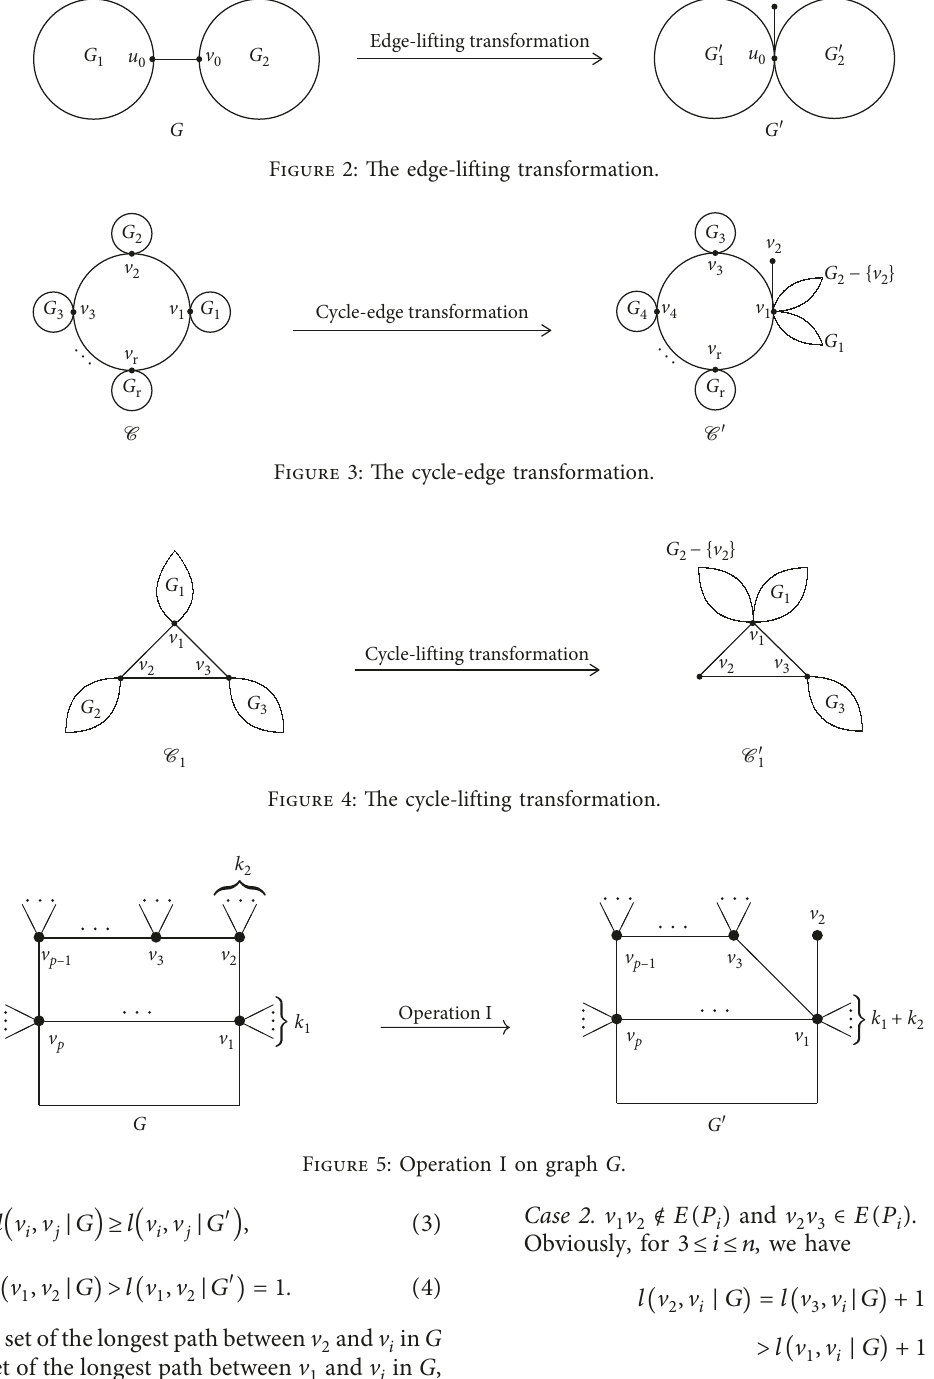
Figure 5: Operation I on graph G